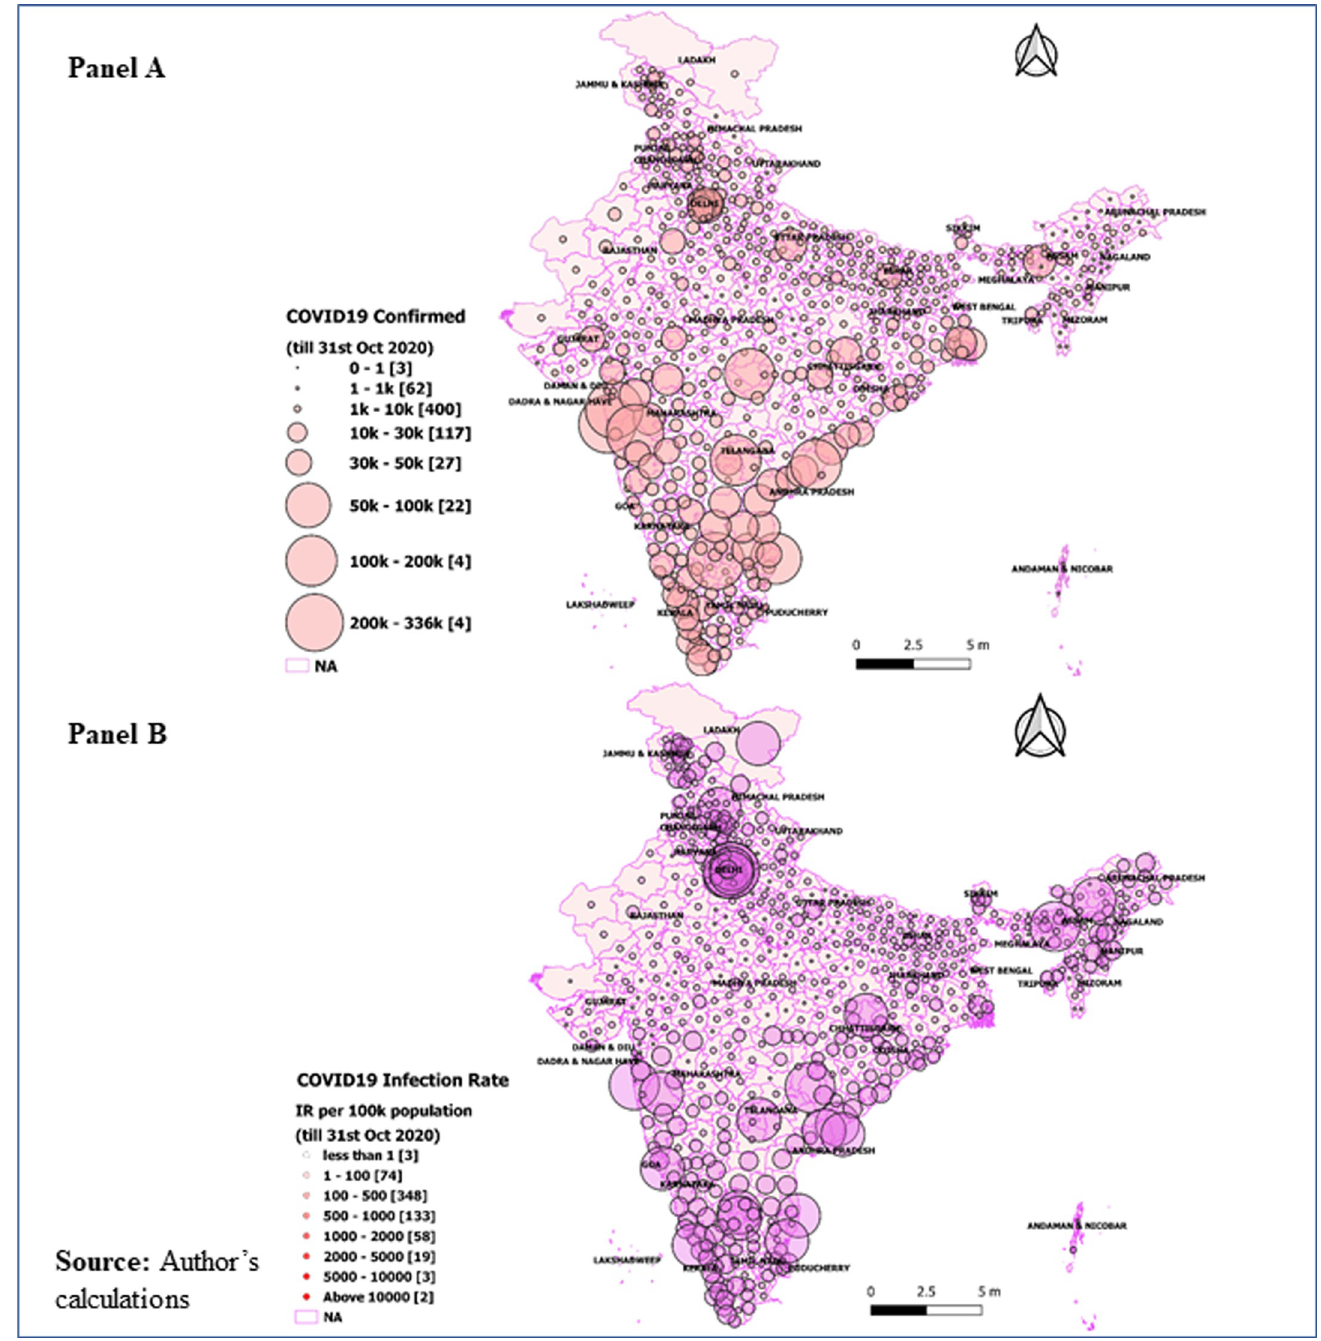
Fig 3. District-level variations in COVID-19 till October 31, 2020. Panel A: Absolute number of COVID-19 cases in districts till October 31, 2020; Panel B: District level infection ratio (IR), defined as the number of confirmed cases per 100,000 population by October 31, 2020.